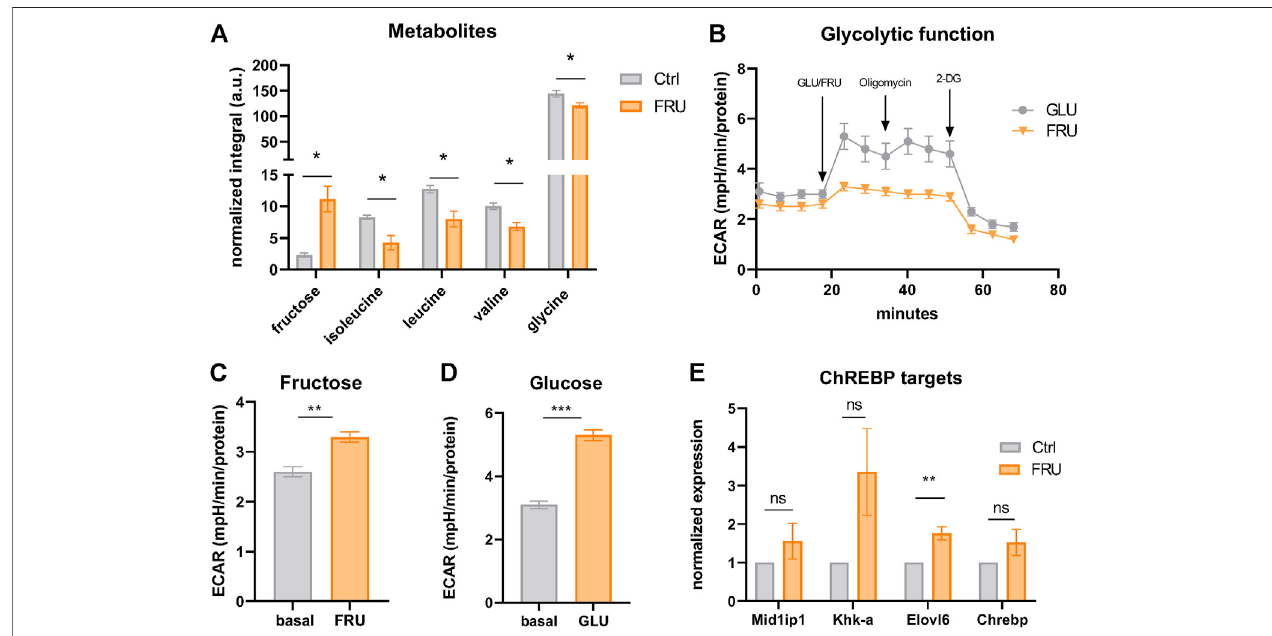
FIGURE5| Fructoseistakenupandmetabolizedbybrownadipocytes. (A) Abundanceofintracellularfructoseandtheaminoacidsisoleucine,leucine,valine,and glycine in iBACs cultivated in growth medium or supplemented with 5 g/L fructose measured by nuclear magnetic resonance (NMR). (B) Continuous extracellular acidi fi cation rate (ECAR) in BACs after the injection of 5 g/L fructose or glucose. Oligomycin and 2-deoxyglucose (2-DG) were acutely injected after measuring basal ECAR. (C,D) Basal ECAR (analyzed after 20 min of measurement) and stimulated ECAR after acute infusion of 5 g/L fructose (C) or glucose (D) . (E) mRNA expression of ChREBP target genes in iBACs kept in growth medium or supplemented with 5 g/L fructose. Mean values ± SEM are shown, signi fi cant differences in the mRNA expression of intracellular metabolites and seahorse experiments were analyzed by performing an unpaired t-test. For mRNA expression of ChREBP targets, unpaired t-test was performed. Differences not indicated with asterisks or indicated with ns are not statistically signi fi cant ( p > 0.05). *** p < 0.001, ** p < 0.01, and * p < 0.05.